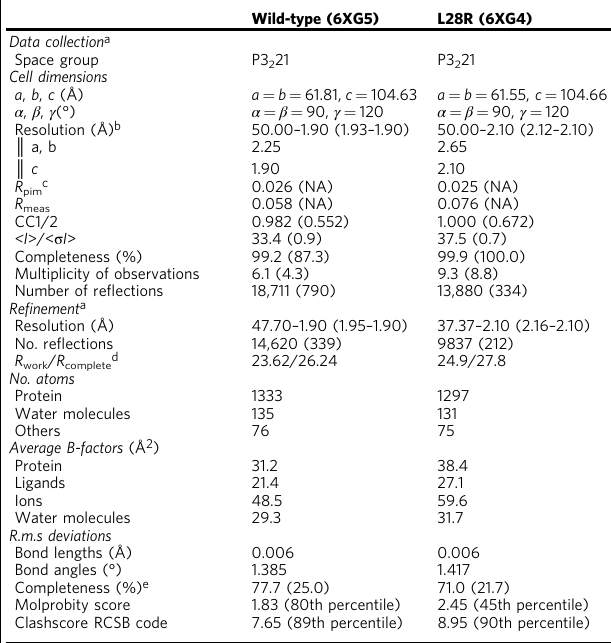
Table 1 Data processing and re fi nement statistics for